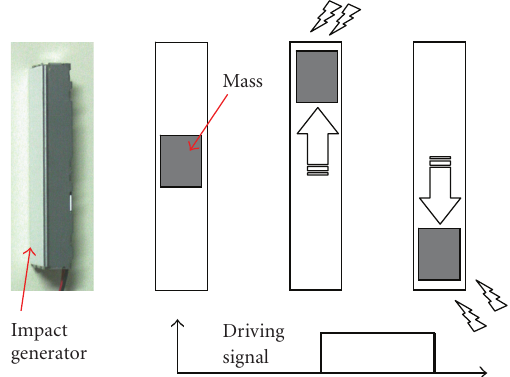
Figure 4: Operation principle of an impact